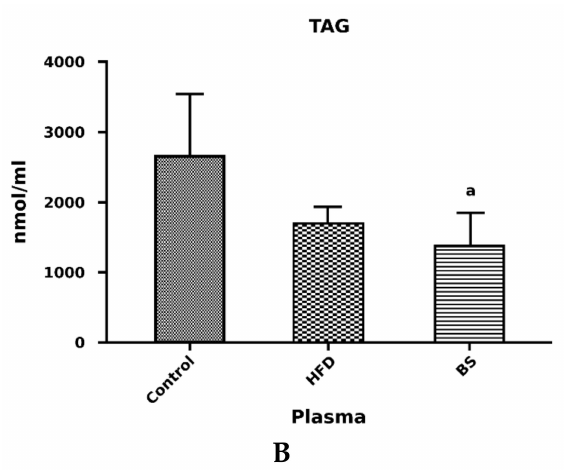
Figure 2. Concentrations of free fatty acids (FFA) (nmol / mL) ( A ) and triacylglycerols (TAG) (nmol / mL) ( B ) in blood plasma. Bar heights correspond to averages and error bars represent standard deviations.